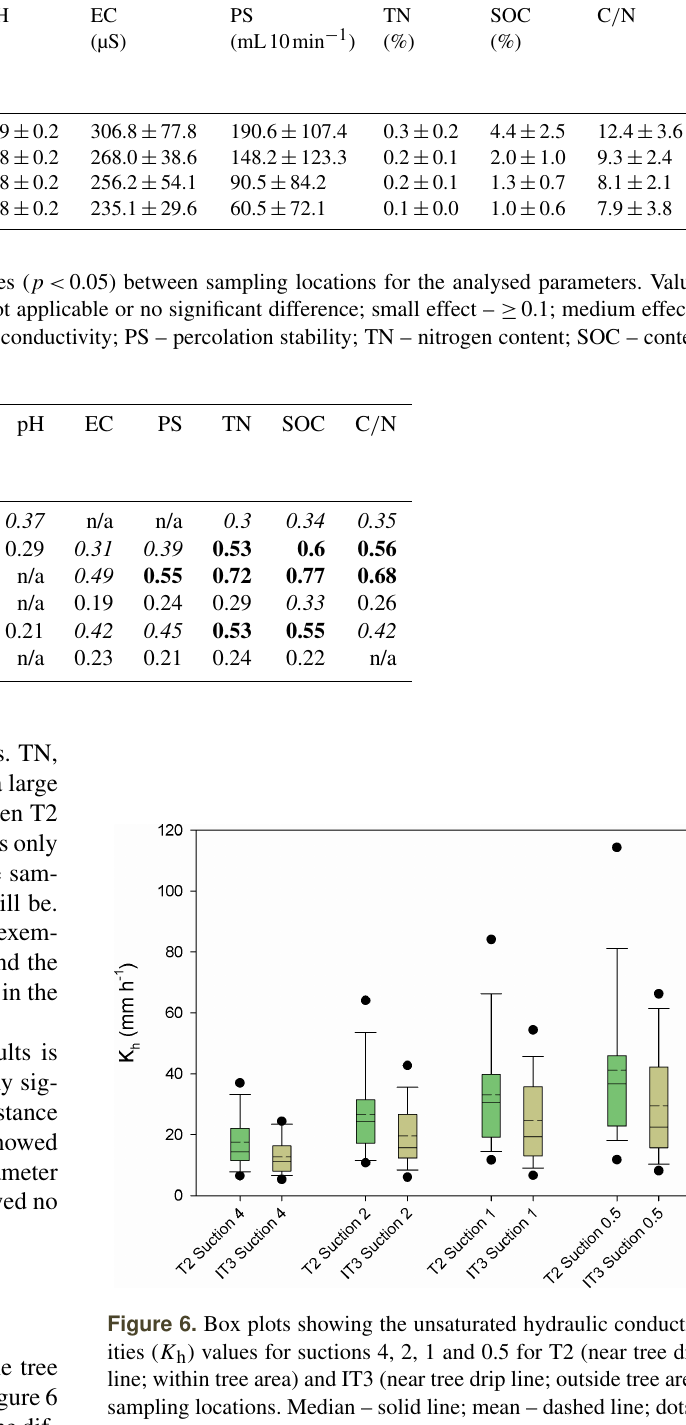
Table 1. Mean and standard deviation values for analysed parameters for T1 (near tree trunk), T2 (near tree drip line; within tree area), IT3 (near tree drip line; outside tree area) and IT4 (intertree area between two trees) samples. EC – electrical conductivity; PS – percolation stability; TN – total nitrogen content; SOC – content of soil organic carbon; C / N is the C / N ratio. Parameter/ sample